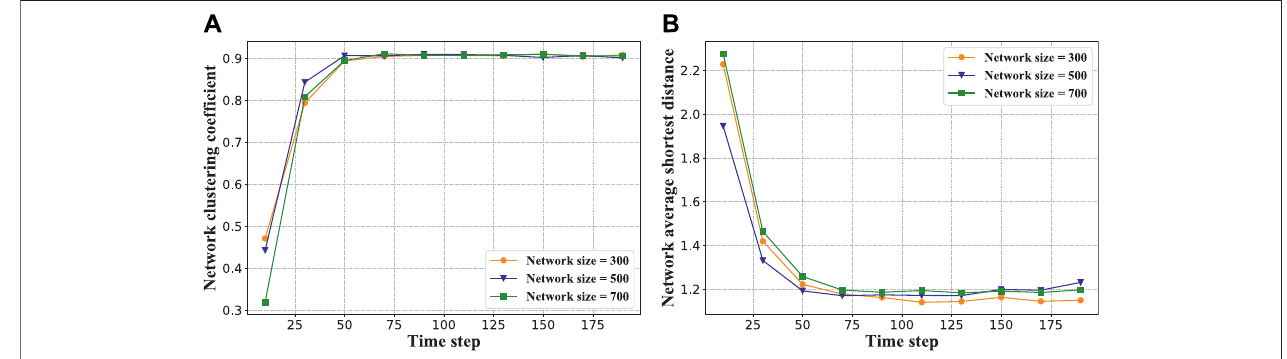
FIGURE5 | Demonstration ofnetwork evolution process in thelow dimensional vector spacewithparameters γ (cid:1) 0.2, ϵ (cid:1) 0.2, networksize (cid:1) 500, (A) t (cid:1) 1, (B) t (cid:1) 3, (C) t (cid:1) 5, (D) t (cid:1) 10, (E) t (cid:1) 20, (F) t (cid:1) 50, (G) t (cid:1) 100, (H) t (cid:1) 150, (I) t (cid:1) 200.